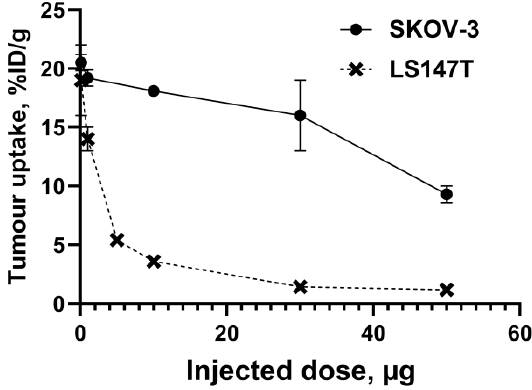
Figure 6. Influence of the injected affibody mass on the uptake of the [ 111 In]-In-DOTA-ZHER2:342 affibody molecule in tumor xenografts with high (SKOV-3) and low (LS174T) levels of HER2 expression. The optimal injected mass is directly connected with the desirable molar activity of affibody- based imaging probes for clinical translation. A clinical study concerning the imaging of HER2 using 68 Ga-labeled ABY-025 affibody molecules demonstrated that an injected activity of 212 ± 46 MBq permits a good imaging quality up to 4 h after injection [54] and is associated with an acceptable effective dose (5–6.4 mSv) [77]. In that study, a molar activity of about 3.8 MBq/µmol (injected mass